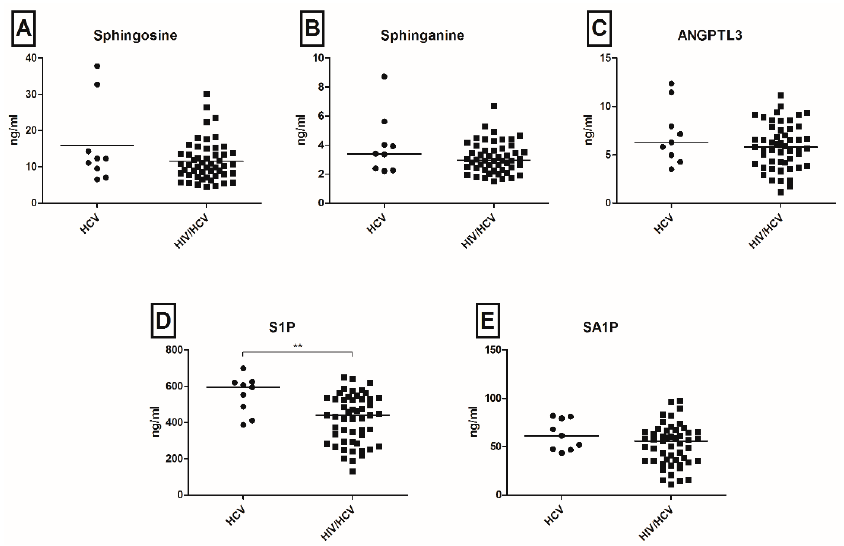
Figure 1. Serum sphingolipids (SLs) and angiopoietin-Like 3 (ANGPTL3) in hepatitis C virus (HCV)-mono-infection and in HCV/human immunodeficiency virus (HIV)-coinfection at baseline. S1P levels in HCV/HIV-coinfected patients were lower than in HCV-mono-infected patients (( D ), ** p < 0.01) at baseline. No significant differences in the levels of further SL metabolites ( A , B , E ) and ANGPTL3 ( C ) were observed among mono- and co-infected patients. S1P: sphingosine 1-phosphate; SA1P: sphinganine 1-phosphate; ANGPTL3: angiopoietin-like 3.